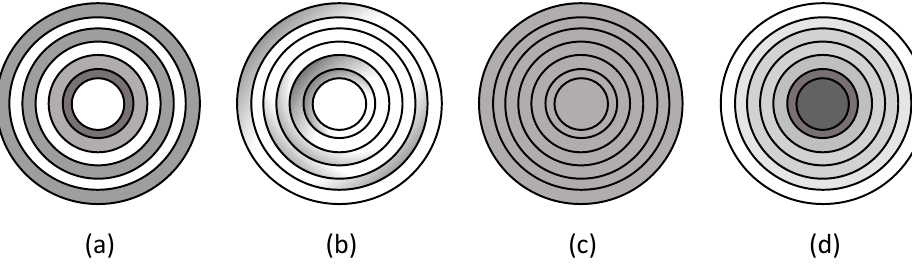
Figure 4. Schematic view of the possible distribution of the elements in tree rings. Gradations of grey colors denote the differences in elemental concentrations. Black circumferences simulate boundaries between tree rings. Legend: ( a ) a regular distribution of elements uniformly around the circle, ( b ) a possible irregular distribution of elements around the circle, ( c ) a regular distribution of elements uniformly around the circle with a low variation across the rings, ( d ) a regular distribution around the circle with a non-random steady trend across the